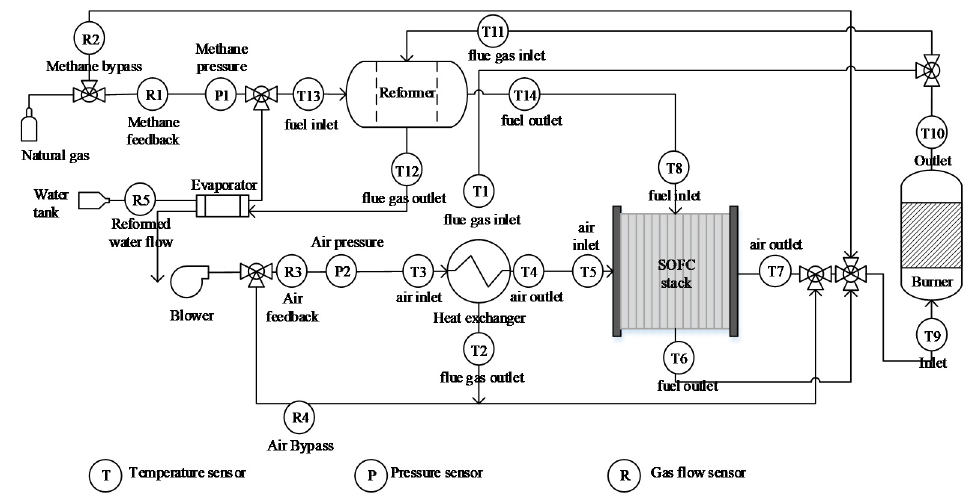
Figure 1. Schematic diagram of the steam reforming solid oxide fuel cell (SOFC) system.